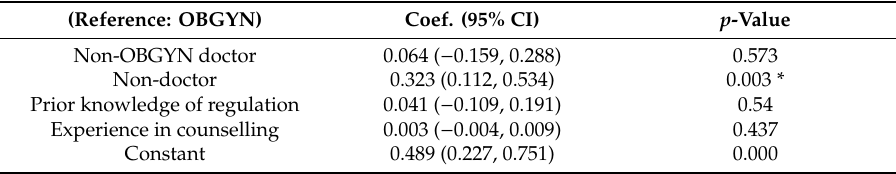
Table 6. Least-squares regression analysis on the abortion